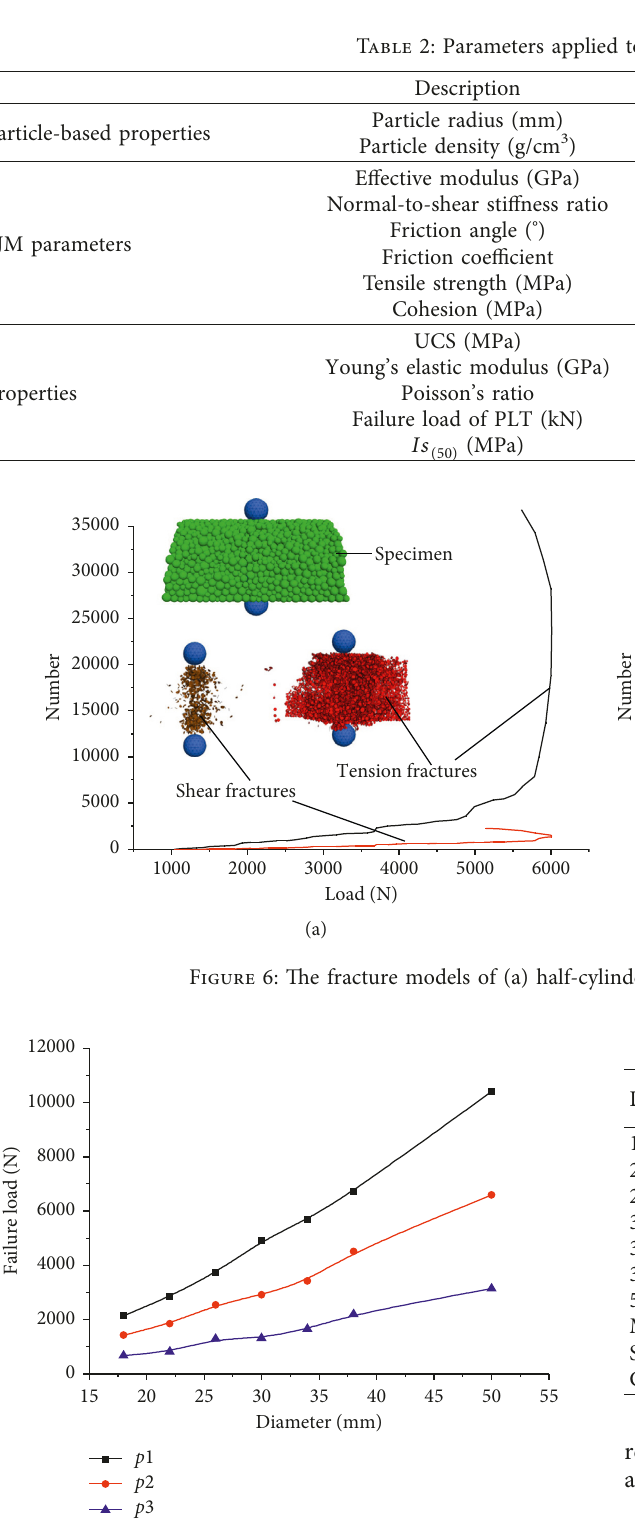
Figure 7: Results of the failure load with various diameters on the cylinder specimens.